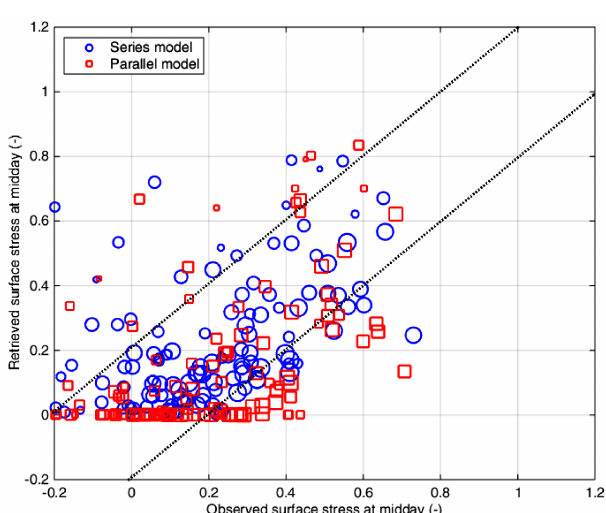
Figure 8. Scatterplot of retrieved vs. observed surface bounded wa- ter stress at midday at the rainfed wheat site (marker size propor- tional to potential evapotranspiration).